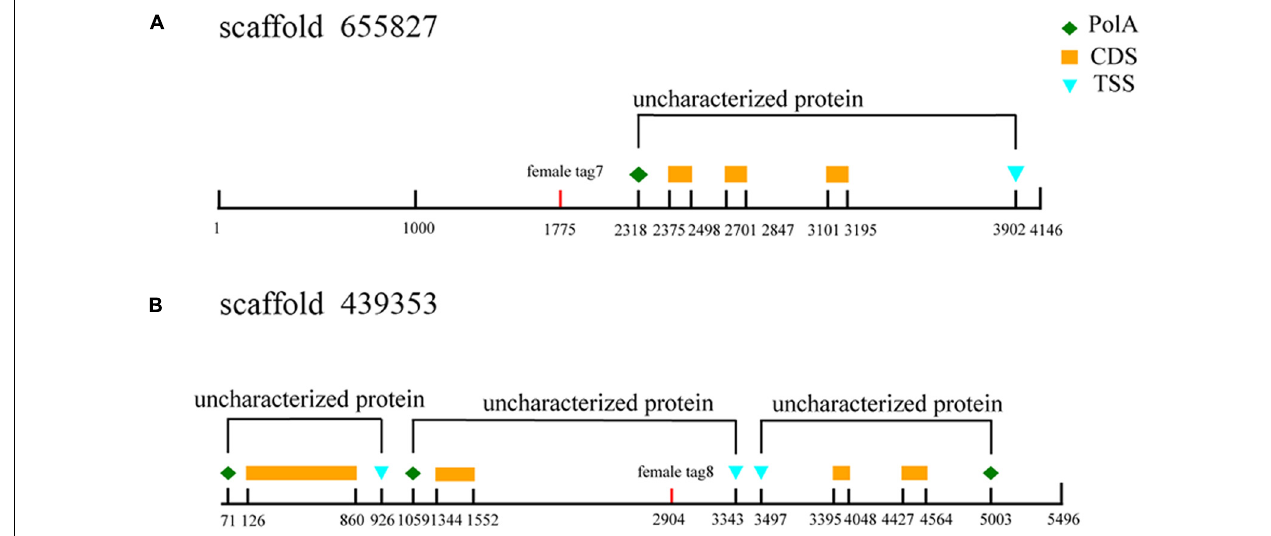
FIGURE 9 | Annotation of sex-specific sequences obtained in M. nudus . Poly A, poly adenylic acid; CDS, coding sequence; TSS, transcriptional start site. (A) Annotation of scaffold 655827. (B) Annotation of scaffold